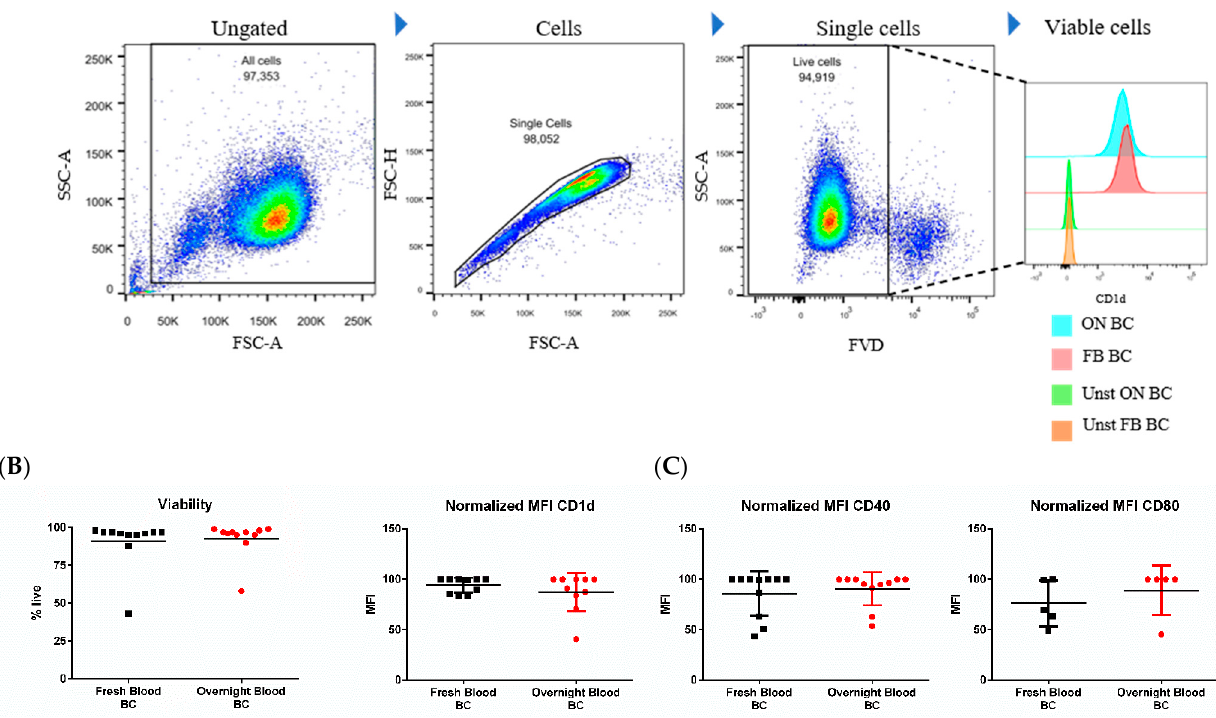
Figure 3. Monocyte viability; CD1d, CD40, and CD80 expression. ( A ) Representative example of gating strategy applied and of the histogram for CD1d expression with unstained samples in the last two peaks (orange and green) and stained samples in the upper peaks (red and blue). FB BC: Fresh Blood Buffy Coat; ON BC:Overnight Blood Buffy Coat; Unst ON BC:Unstained Samples from Overnight Blood BC; Unst FB BC:Unstained Samples from Fresh Blood BC. ( B ) Percentage of live cells in the experiments from the two types of Buffy Coat (BC). Monocyte viability was measured by flow cytometry using Fixable Viability Dye (FVD). ( C ) Normalization of the values of CD80, CD40, and CD1d MFI for each independent experiment. The values of MFI were relativized considering 100 as the highest value within each experiment for the chosen superficial marker. Statistical analysis was performed by t -test. Horizontal bars represent mean and vertical bars ± SD.